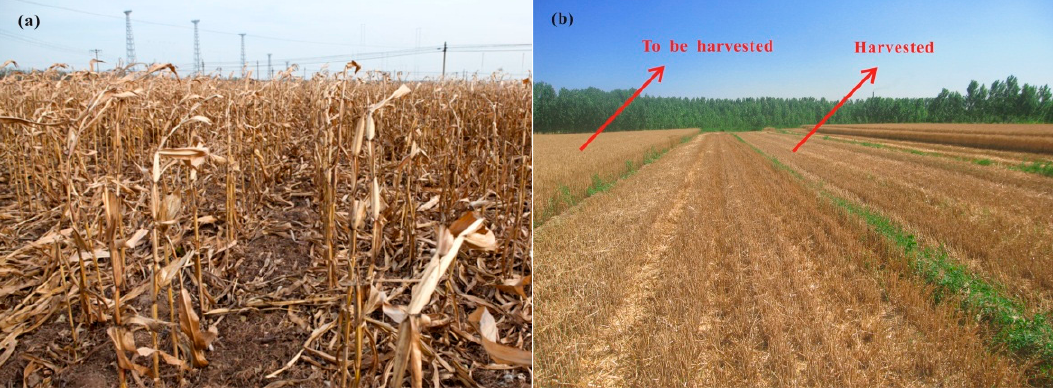
Figure 9. Photographs of: ( a ) maize residue; and ( b ) wheat residue.